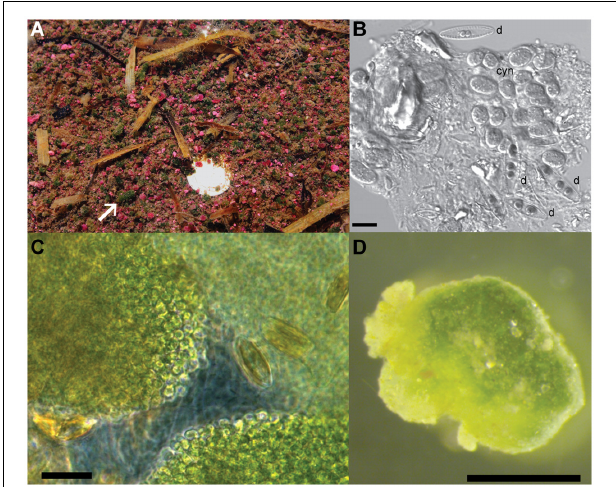
FIGURE 1 | Morphology of the green berries. (A) Pink and green berries at the sediment water interface of intertidal pools in the Little Sippewissett salt marsh. White arrow indicates a large green berry and a dime (bright spot) is provided for scale. (B) Differential interference contrast (DIC) micrograph of cells from a homogenized green berry showing two different pennate diatom morphotypes (d) and clumps of coccoid unicellular cyanobacteria 5–7 µ m in diameter (cyn). Scale bar = 10 µ m. (C) Phase contrast image of an intact green berry aggregate compressed under a coverslip. Note the dense clumps of coccoid cyanobacterial cells and pennate diatoms interspersed in a clear exopolymer matrix. Scale bar = 10 µ m. (D) Dissecting microscope image of a single green berry aggregates. Scale bar = 1 mm.